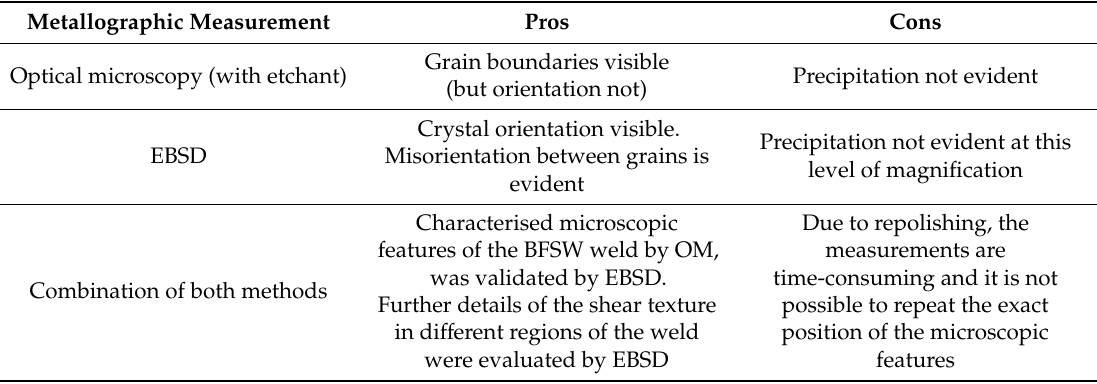
Table 3. Comparative details of the metallographic measurements performed for the bobbin friction stir welding (BFSW) A6082-T6 weld structure by optical microscopy (OM) and EBSD. Metallographic Measurement Pros Cons Grain boundaries visible Precipitation not evident Optical microscopy (with etchant) (but orientation not) Crystal orientation visible. Precipitation not evident at this EBSD Misorientation between grains is level of magnification evident Due to repolishing, the Characterised microscopic features of the BFSW weld by OM, measurements are was validated by EBSD. Combination of both methods Further details of the shear texture in di ff erent regions of the weld were evaluated by EBSD